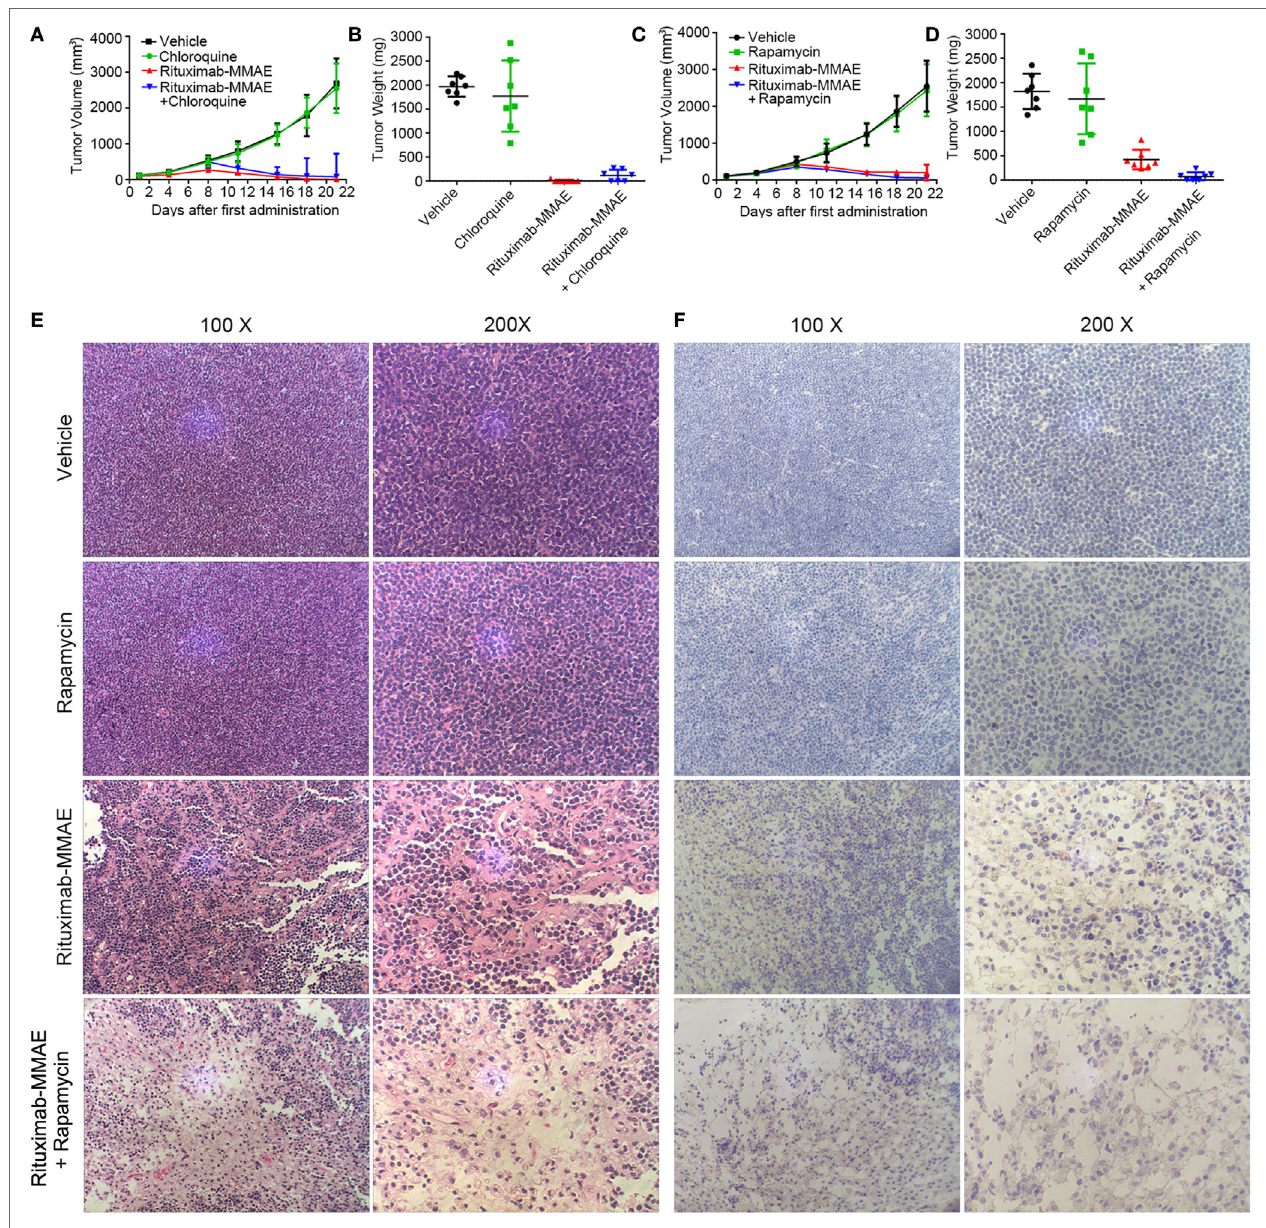
FigUre 6 | Activation of autophagy enhanced antitumor efficacy of Rituximab-monomethyl auristatin E (MMAE) in vivo . (a–D) BABL/c nude mice were transplanted subcutaneously with Ramos cells. Xenograft tumor volume was evaluated every other day by direct caliper measurements. There are seven mice in each group. The data were presented as means ± SD. Tumor weight was presented as mean ± SD, and each point represented a value from an independent mouse. (e) H&E staining images of Ramos xenograft tumors treated with Rituximab-MMAE with or without rapamycin. (F) Images of immunohistochemistry caspase 3 staining of Ramos xenograft tumors treated with Rituximab-MMAE with or without